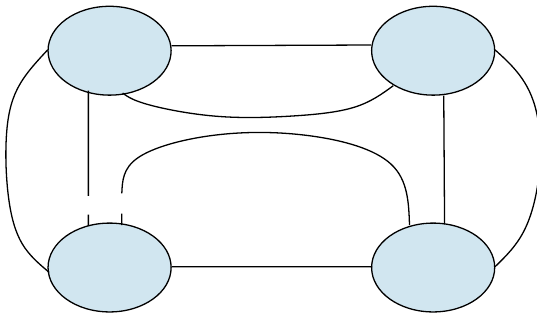
evaluated at the identity. Each oval @U